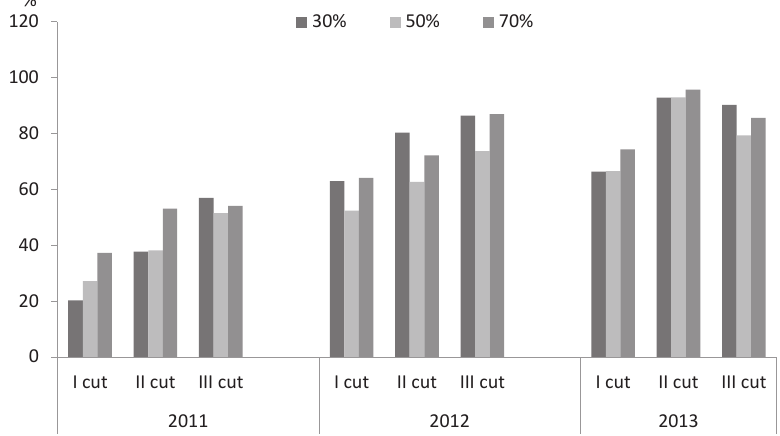
Fig. 1. The share of alfalfa in the yields of mixtures with various proportions of alfalfa (30%,